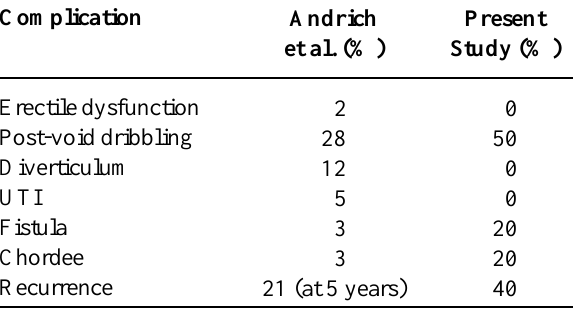
Table 7 – Comparing complications after fasciocutaneous urethroplasty in this study to 84 patients reported at the Institute of Urology in London, Andrich et al. (ref.